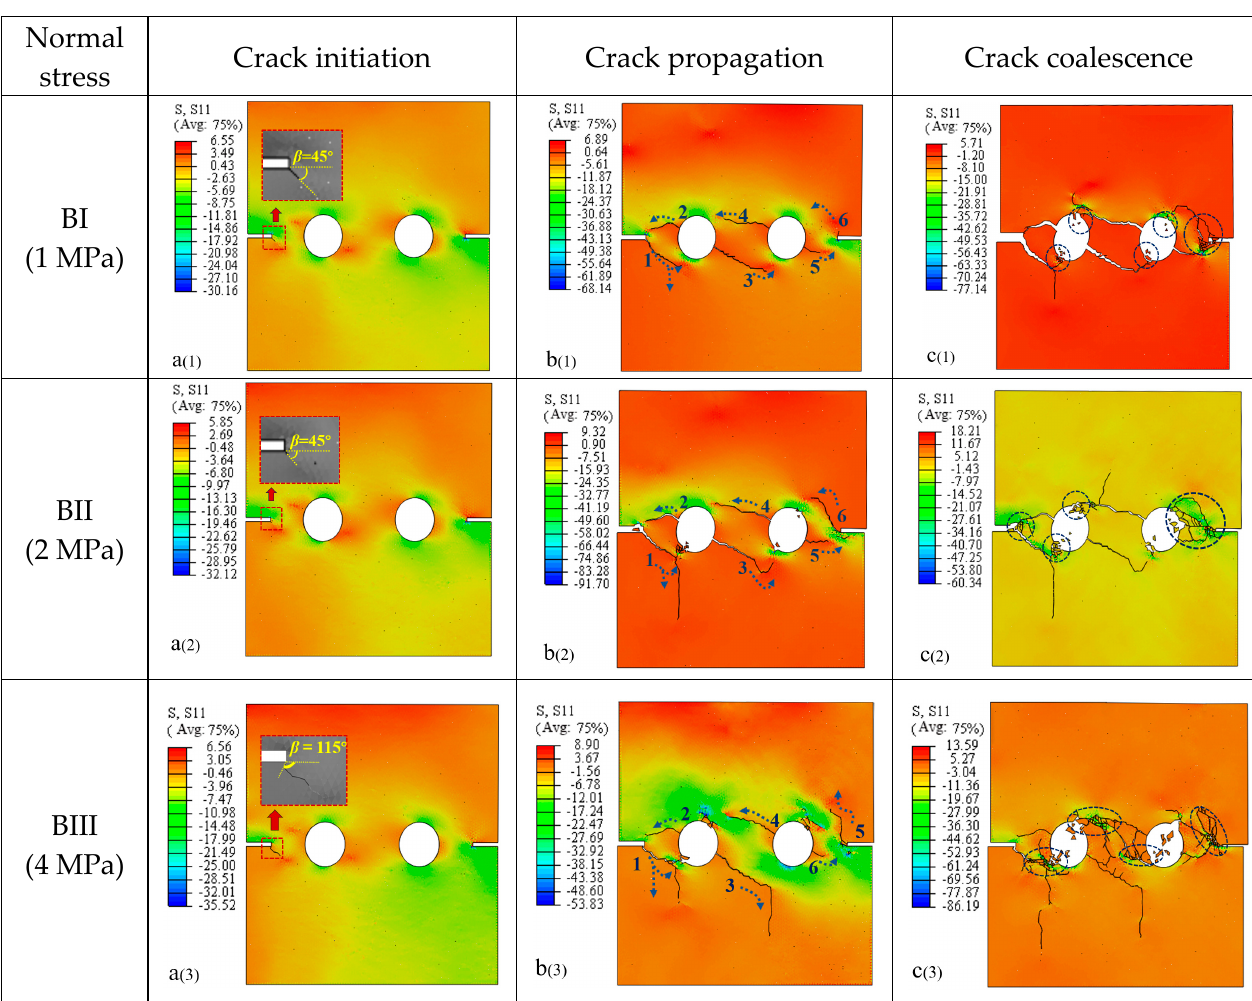
Figure 12. Stress distribution and crack propagation process of rock-like materials under different normal stresses and shear rates of 0.02 mm/s. a(1)–a(3). The stage of crack initiation; b(1)–b(3). The stage of crack propagation; c(1)–c(3). The stage of crack coalescence.